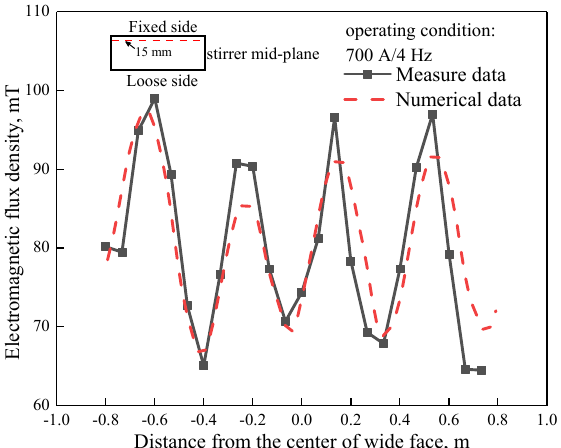
Figure 2. Distribution of measured and numerical magnetic flux density at stirrer mid-plane (Z = − 0.075 m).